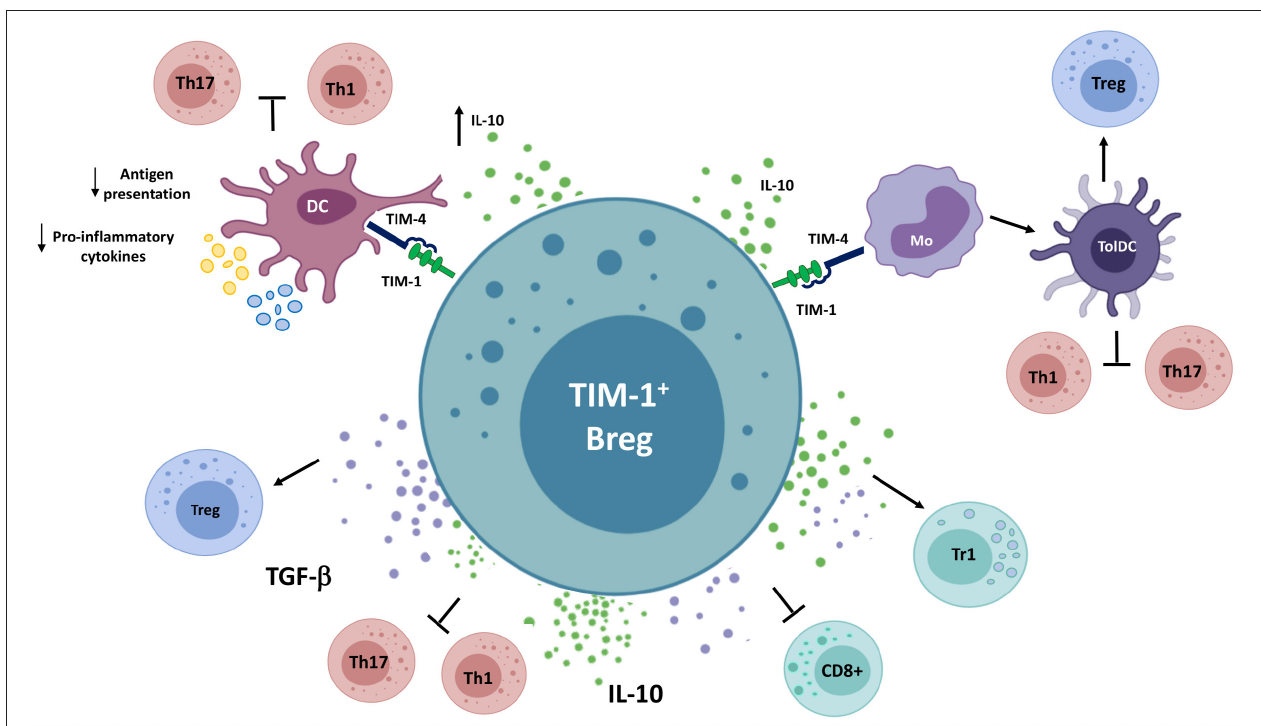
FIGURE 3 | Model of suppression of immune responses by TIM-1 + Bregs. TIM-1 + Bregs secrete IL-10 and TGF- β upon engagement of TIM-1 by phosphatidylserine and possibly by interacting with TIM-4-expressing antigen-presenting cells, inhibiting Th1, Th17, and CD8 + T cells, as well as inducing regulatory T cell populations. These changes could also be mediated indirectly, by decreasing antigen presentation and the production of pro-inflammatory cytokines by dendritic cells (DCs) or modulating monocytes to differentiate into tolerogenic DCs. DC, Conventional dendritic cell; Mo, Monocyte; TolDC, Tolerogenic dendritic cell; Tr1, Type-1 regulatory T